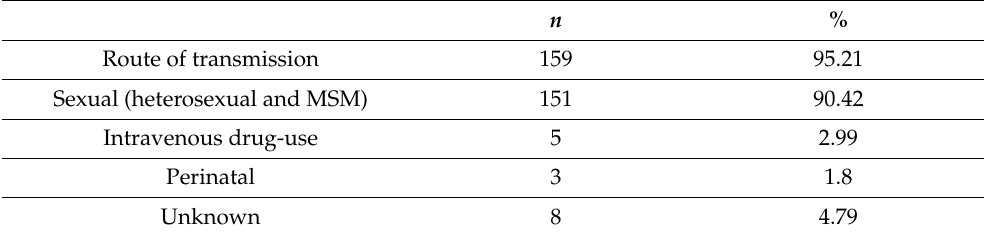
Table 3. Route of transmission of the study group.